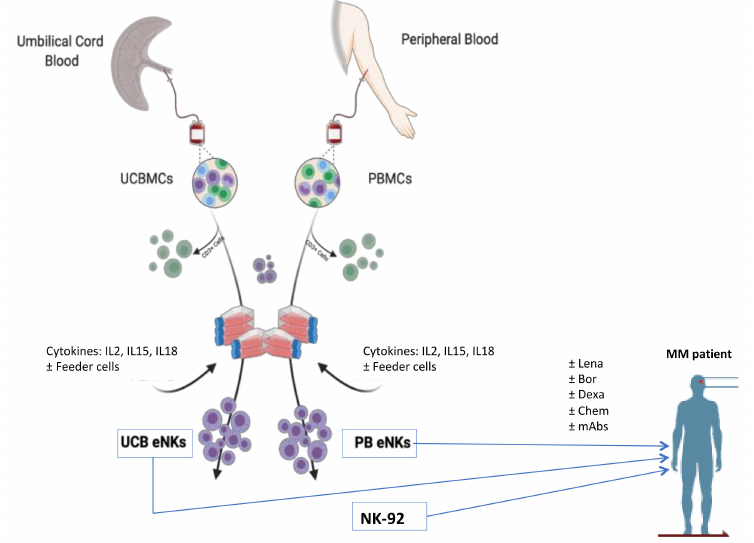
Figure 2. Schematic representation of the main therapeutic protocols described in Section 4.2. Abbre- viations are the same as used in Tables 1 and